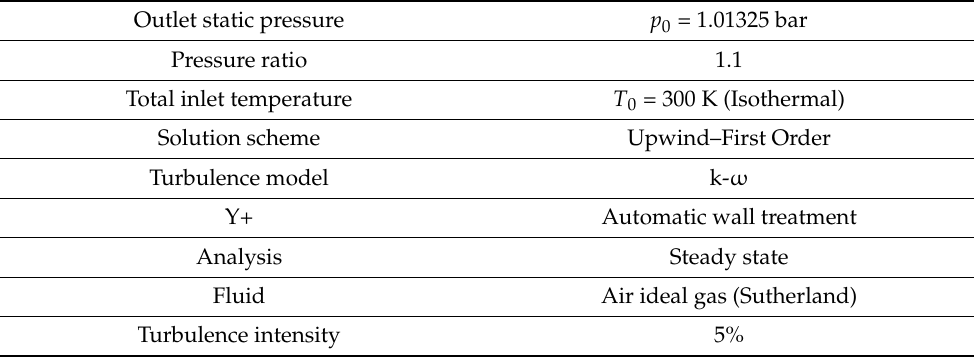
Figure 3. CFD geometry, boundary conditions [19]. Table 4. Setup